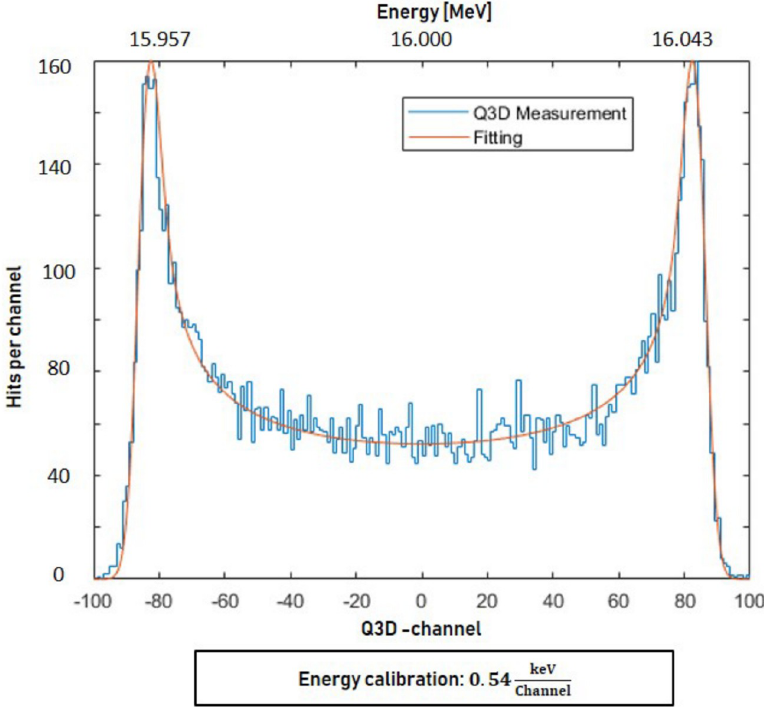
Fig 12. Energy distribution of the bunched protons recorded with the Q3D magnetic spectrograph setup ( P 778 W, 4-gap buncher).